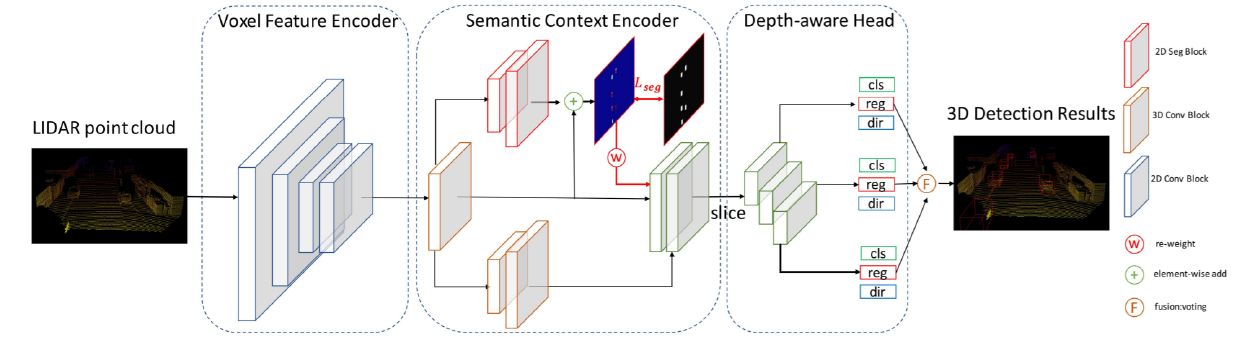
Figure 13. The SegVNet [63] with major components VFE, SCE, and depth aware head. Muramatsu et al. [64] presented their solution by developing the SECOND-DX